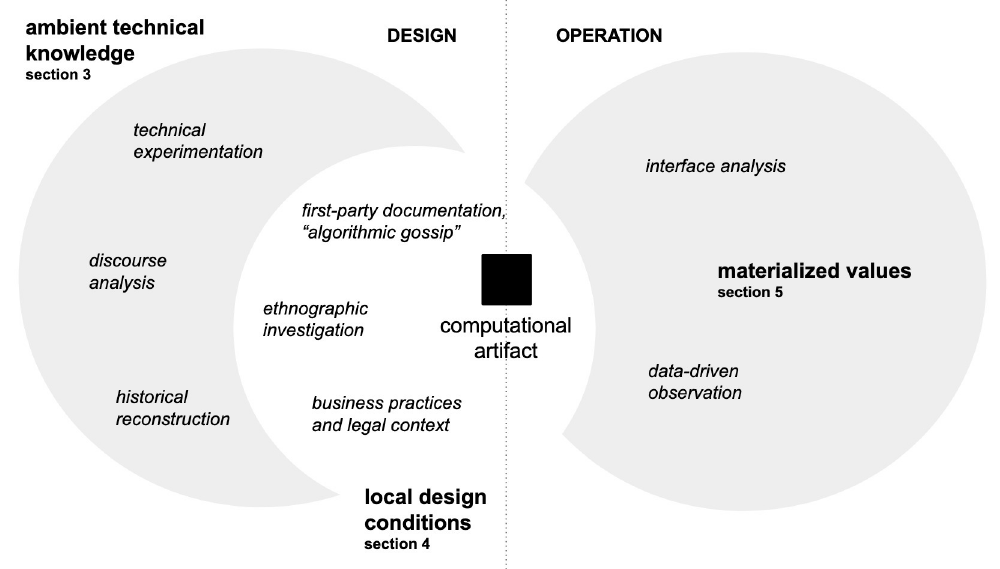
Figure 1: Overview of the three layers of our proposal and their associated methods, covering technical background knowledge and practice, local design conditions, and the system in